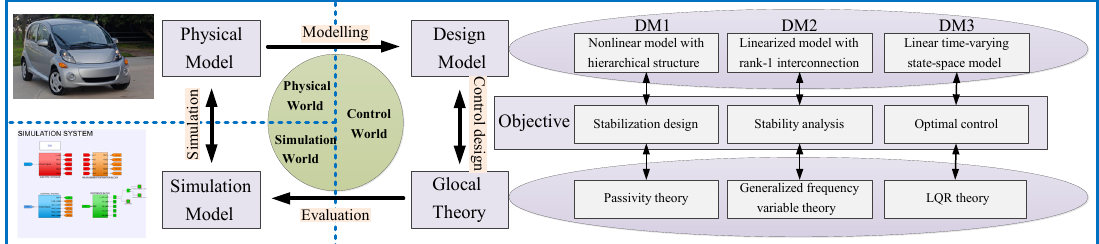
Figure 1. Discussion strategy in this paper: Design procedure of electric vehicles driven by in-wheel-motors (IWM-EV) motion control.